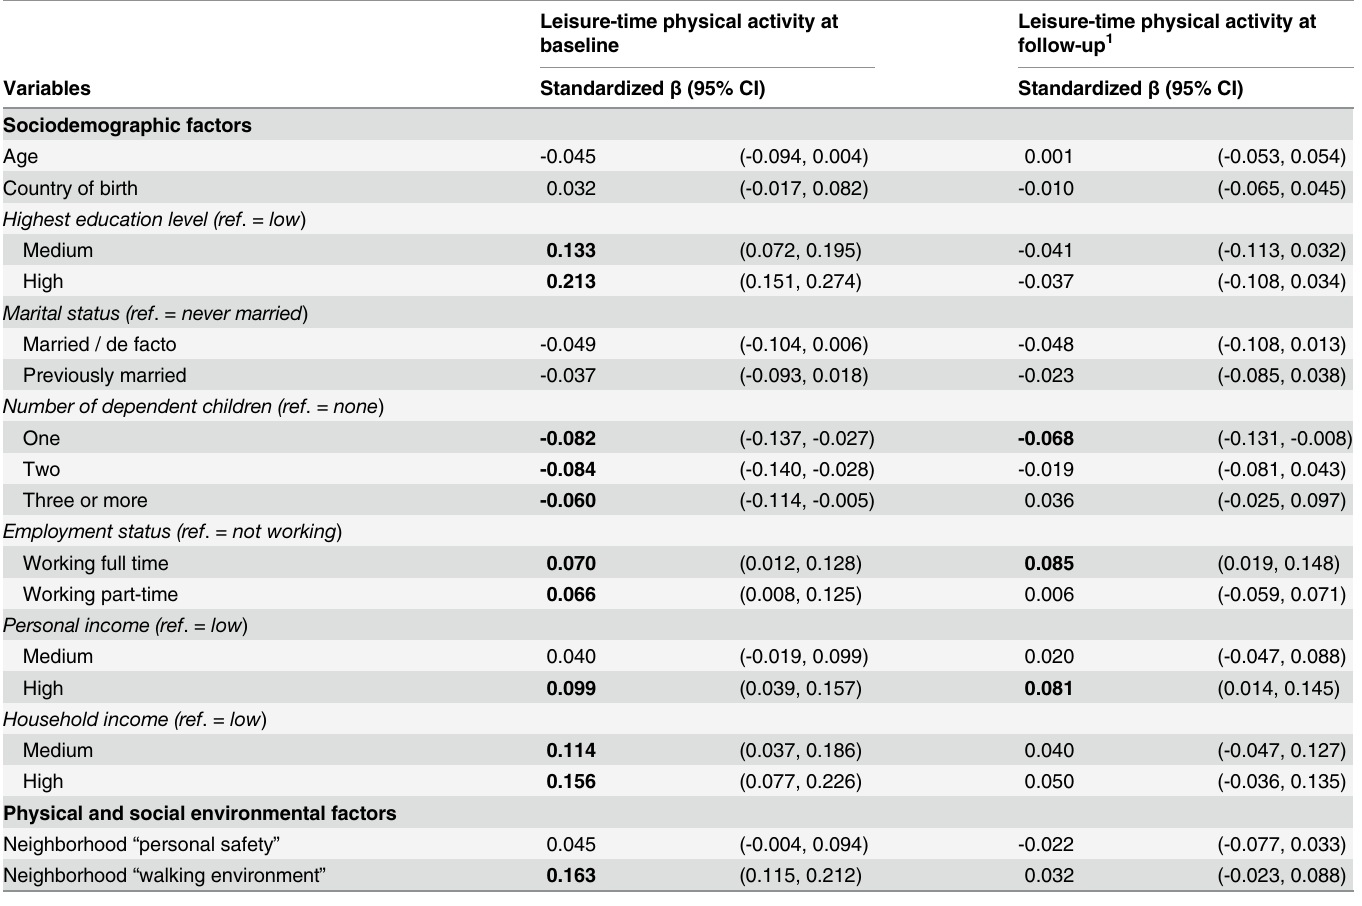
Table 1. Univariate associations of sociodemographic and physical and social environmental factors with leisure-time physical activity.